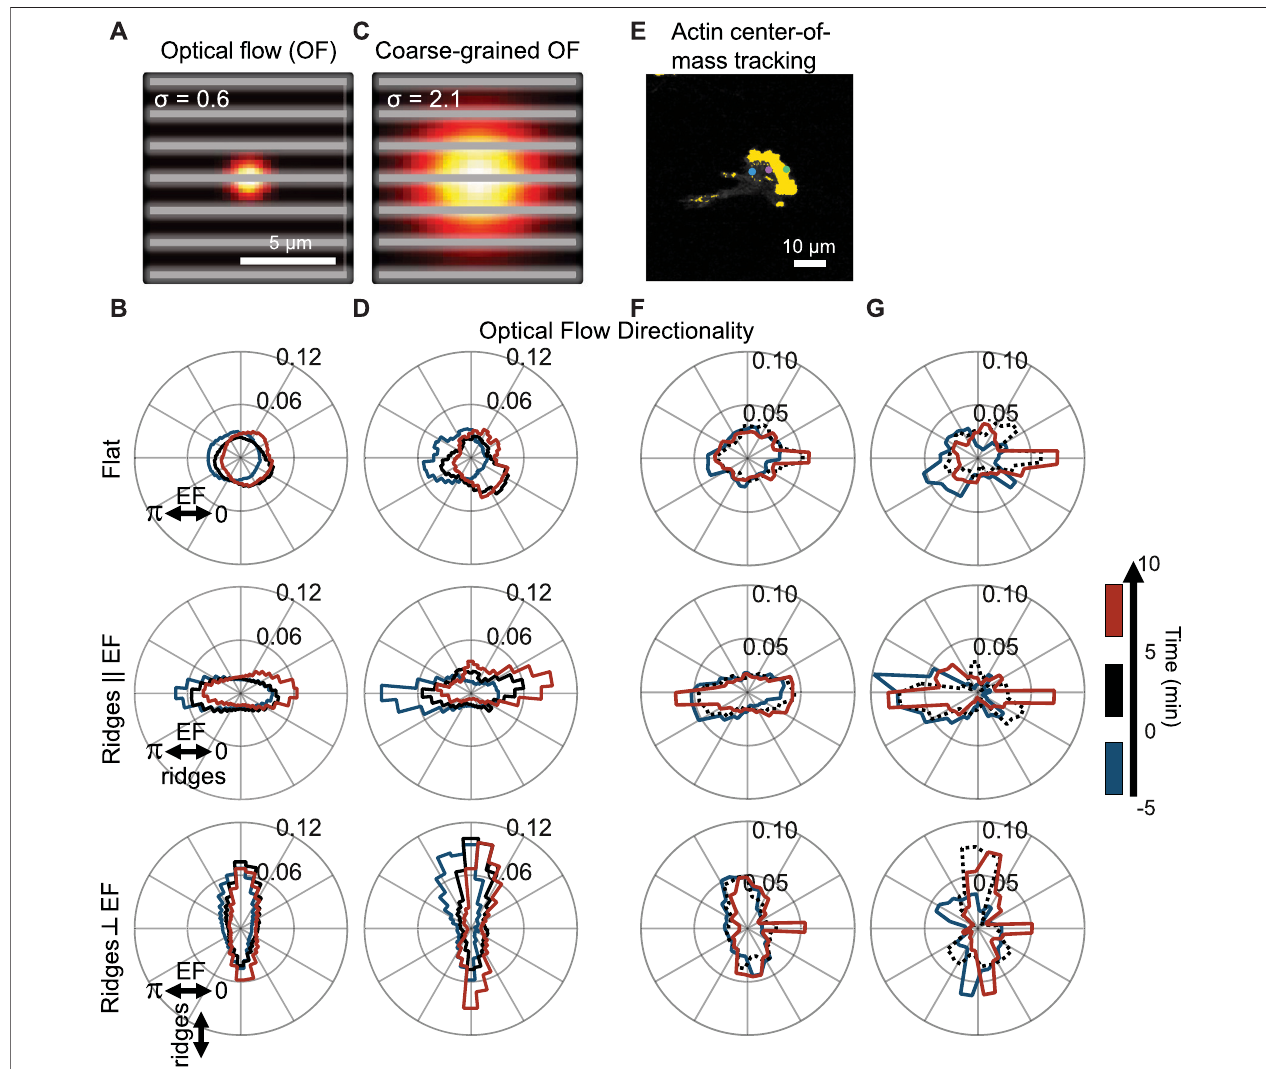
FIGURE4 | Actin dynamicsanalyzed on multiple scales withcooperating and competing nanotopography and EF guidance; actin polymerization ispredominantly guided by nanotopography, but the guidance is biased by the EF. (A) Visualization of spatial scale used for optical- fl ow calculations (gray lines = ridges). (B) Cumulative fl ow-directiondistributionshown forall cellson (top)a fl at substrate, (middle)nanoridgesparallel totheEF, and (bottom)nanoridgesperpendiculartotheEFforthe three time intervals shown on the right. (C) Visualization of the spatial scale used for coarse-grained optical- fl ow calculations to capture larger-scale actin waves. (D) Cumulative fl ow-direction distribution shown for the same time intervals as (B) for all substrate conditions. (E) Visualization of actin center-of-mass tracking via the Crocker-Grieralgorithm(CrockerandGrier,1996),withtrackresultsfromthreetimepointsshown.Actincentroidtrackingforallsubstrateconditionswith (F) dt =2sand (G) dt = 120 s for the same time intervals as (B,D)